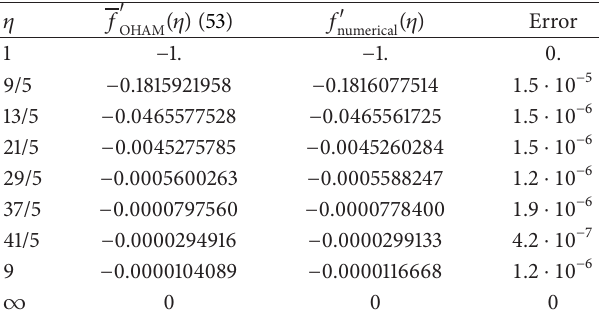
Table 11: Comparison between the derivative 𝑓 (53) and numerical results for 𝛾 = 2 and 𝑆 = −1 (error = |𝑓 (𝜂)| ). 𝑓 󸀠 numerical